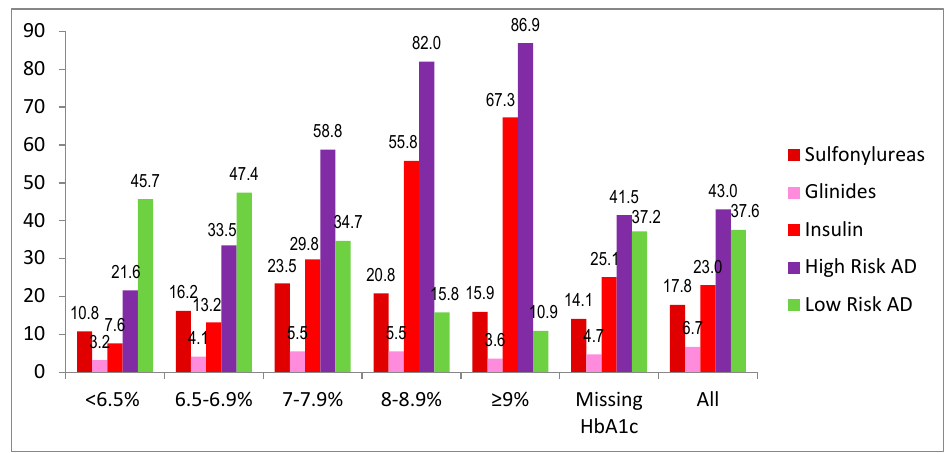
Figure 2. Antidiabetic treatment. ( a ) Steps of antidiabetic treatment by HbA1c categories; ( b ) Use of high-risk antidiabetic drugs by HbA1c categories.